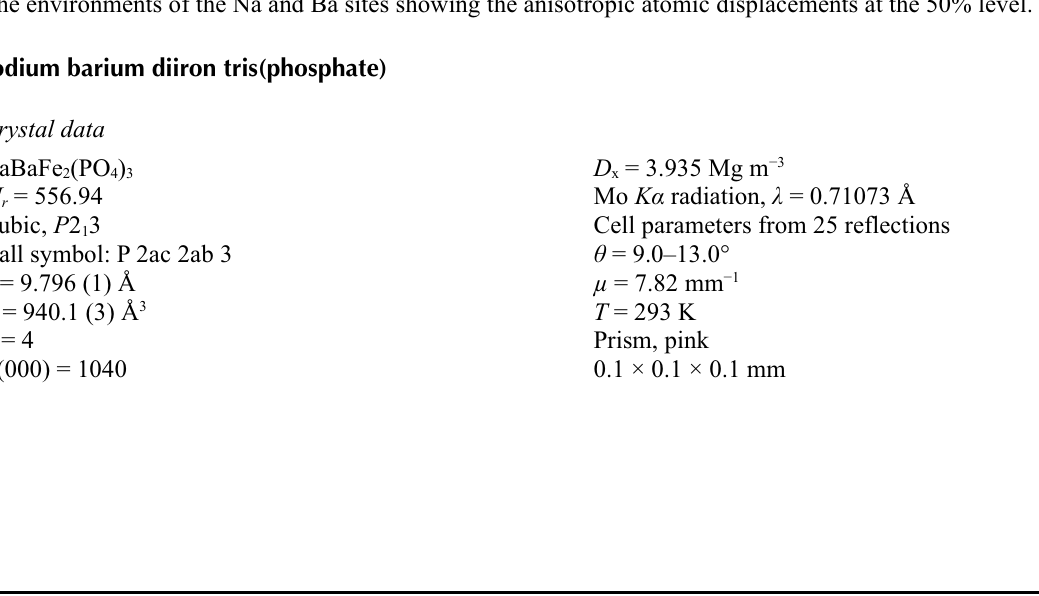
The environments of the Na and Ba sites showing the anisotropic atomic displacements at the 50%